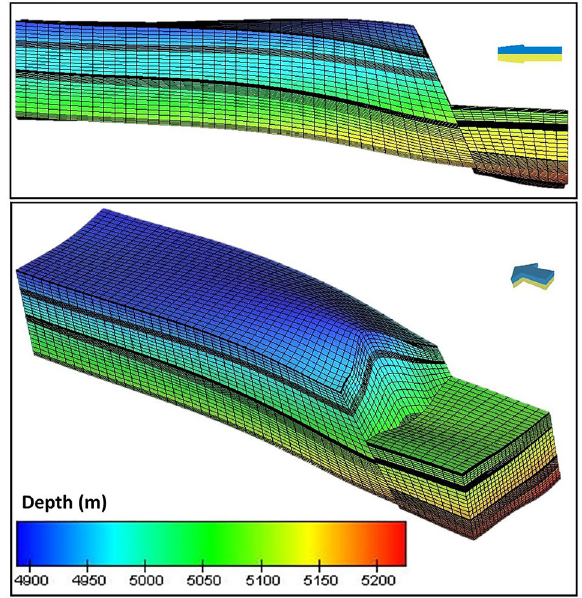
Fig. 2 Simulation grid features